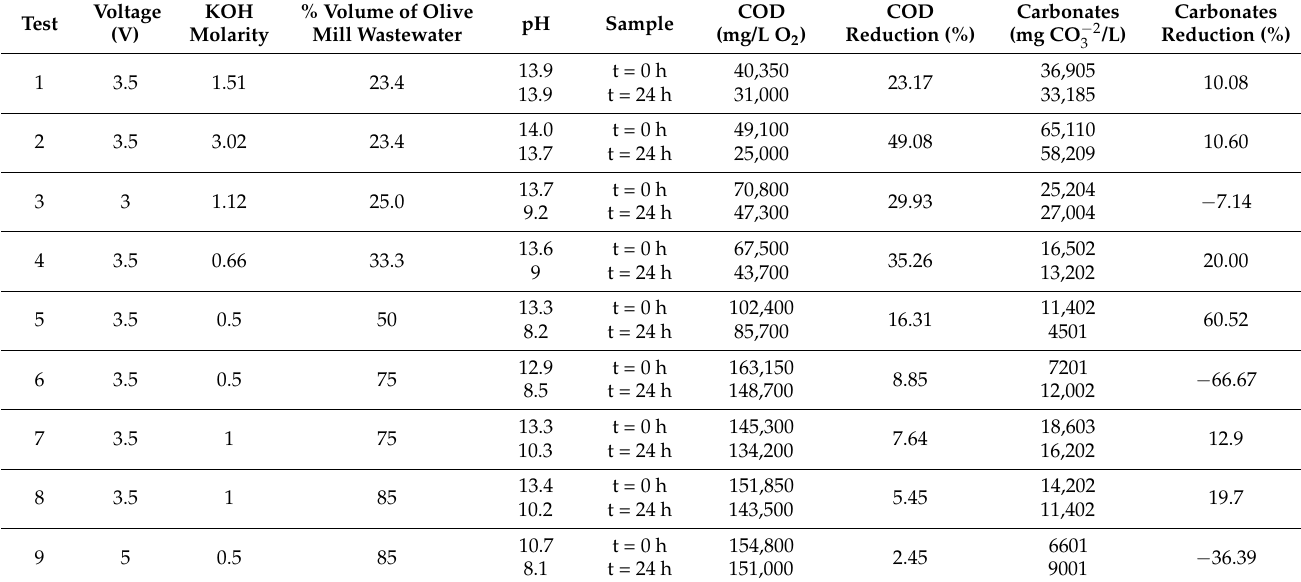
Table 4. Chemical oxygen demand and carbonates at the start and end of several olive mill wastewater electro-oxidation